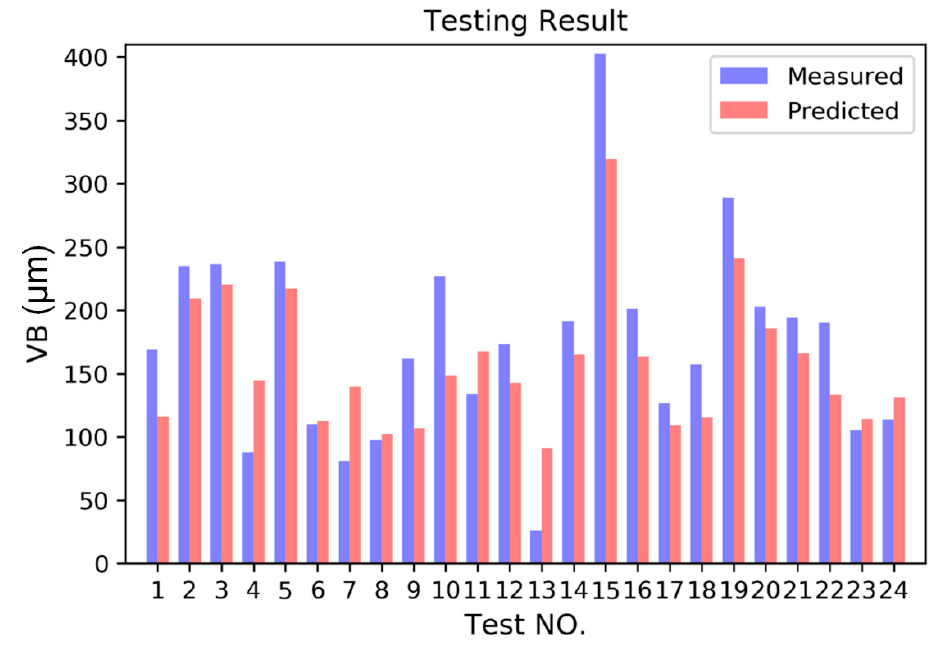
Figure 13. Testing result in 24 samples of the trained deep learning model.